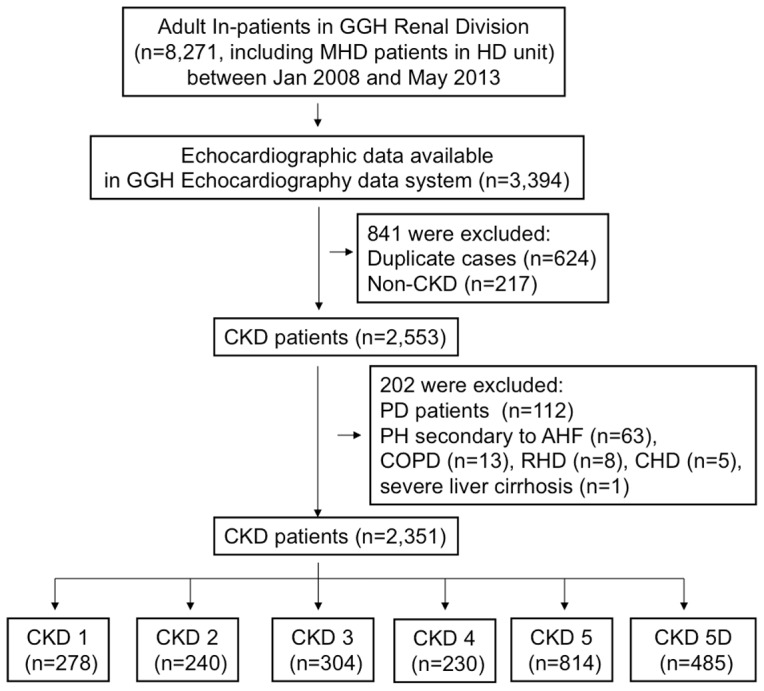
Schematic of study sample with exclusions from analysis.